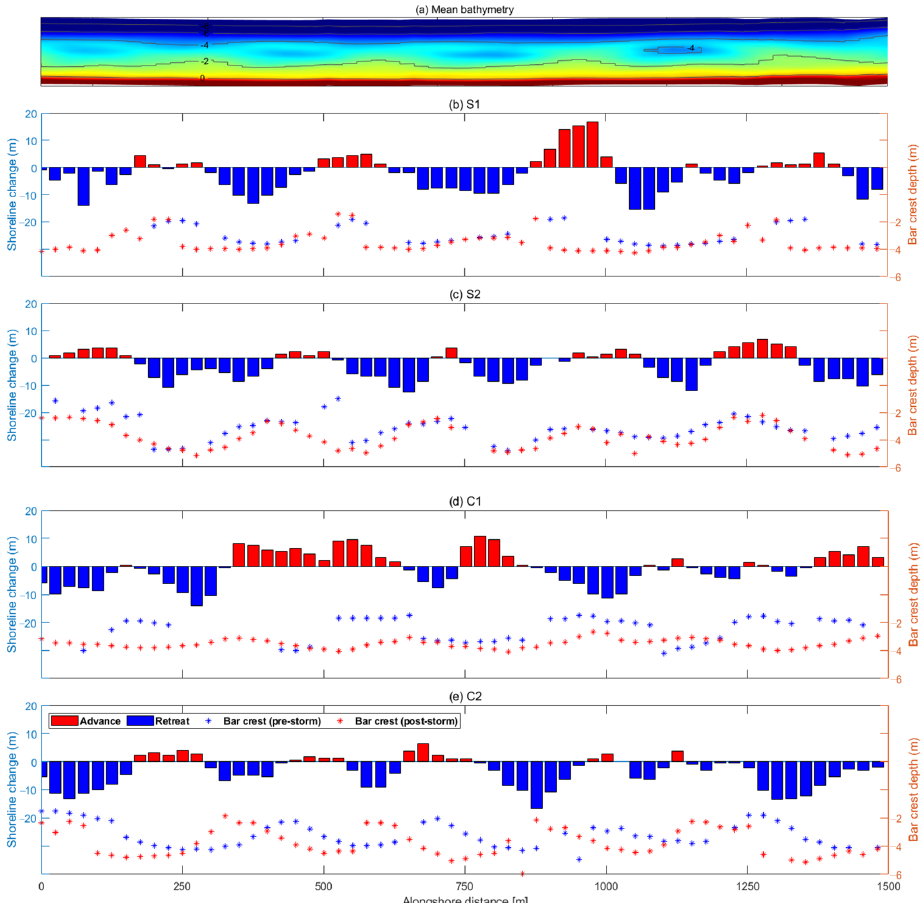
Figure 5. Compared to the mean bathymetry ( a ), migration of nearshore crescentic sandbars and shoreline change in response to each storm event ( b – e ). Blue and red bars (asterisks) denote the shore- line retreat (depth of bar crests pre-storm) and advance (depth of bar crests post-storm),